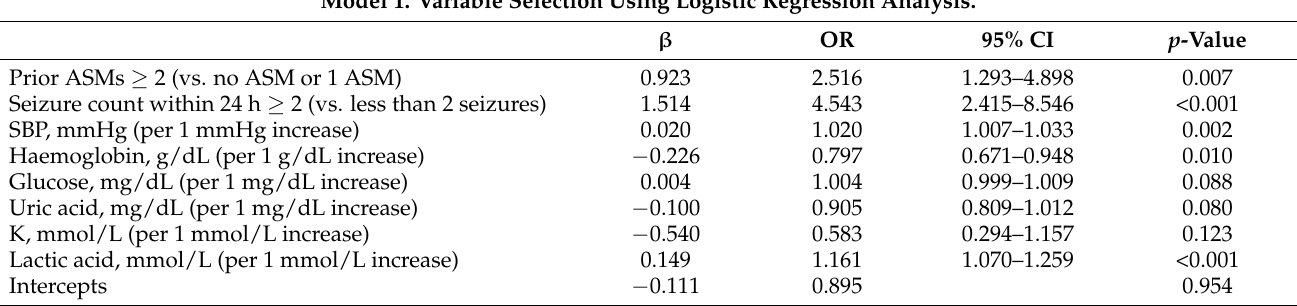
Table 3. Generation of prediction models in the derivation cohort. Model 1. Variable Selection Using Logistic Regression